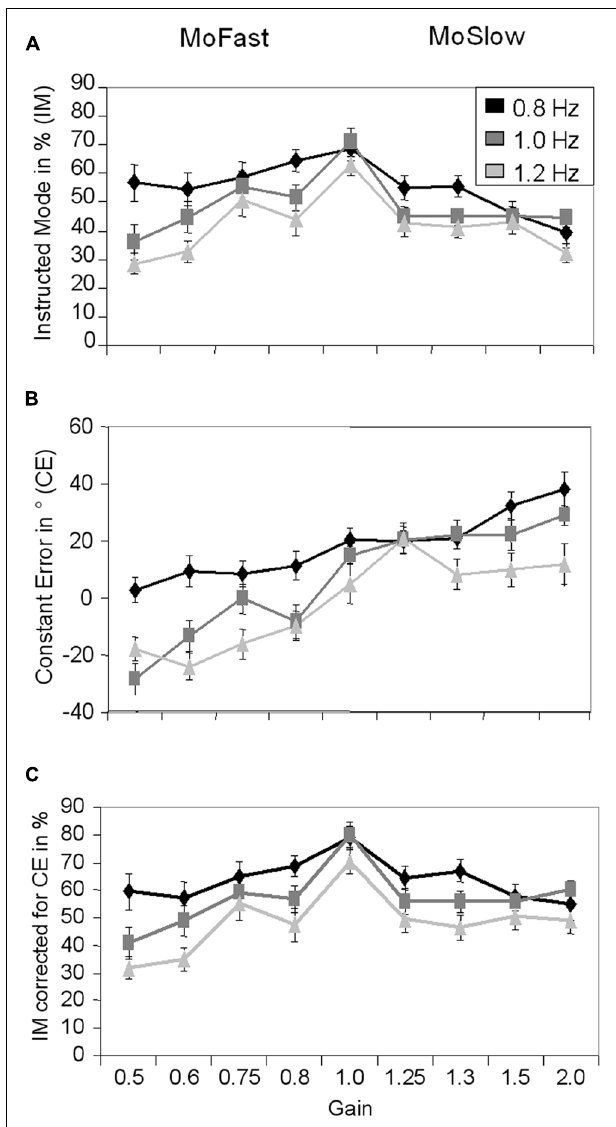
FIGURE 2 | Means and standard errors for Instructed Mode (A), Constant Error (B), and Instructed Mode corrected for Constant Error (C) depending on visual speed and gain. MoFast = gains smaller than 1, movement speed is faster than visual speed. MoSlow = gains higher than 1, movement speed is slower than visual